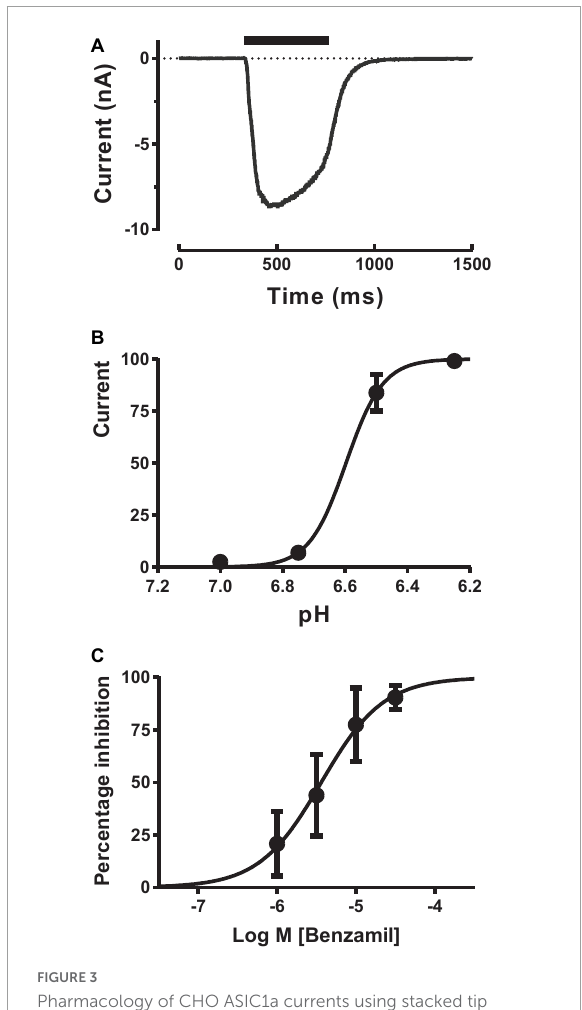
FIGURE3 Pharmacology of CHO ASIC1a currents using stacked tip application on Patchliner. (A) Rapid activation of inward current during pH 6.5 application, followed by desensitization and then rapid wash-off. (B) pH activation reveals an EC 50 of 6.6 ± 0.01 (mean ± S.D, n = 3) with a Hill slope of 7.3. (C) ASIC1a current inhibition by Benzamil. Cumulative application of increasing concentrations of Benzamil before and during repeated stimulus with pH 6.5 solution reveal an IC 50 of 3.65 ± 1.18 µ M (mean ± S.D, n = 3).